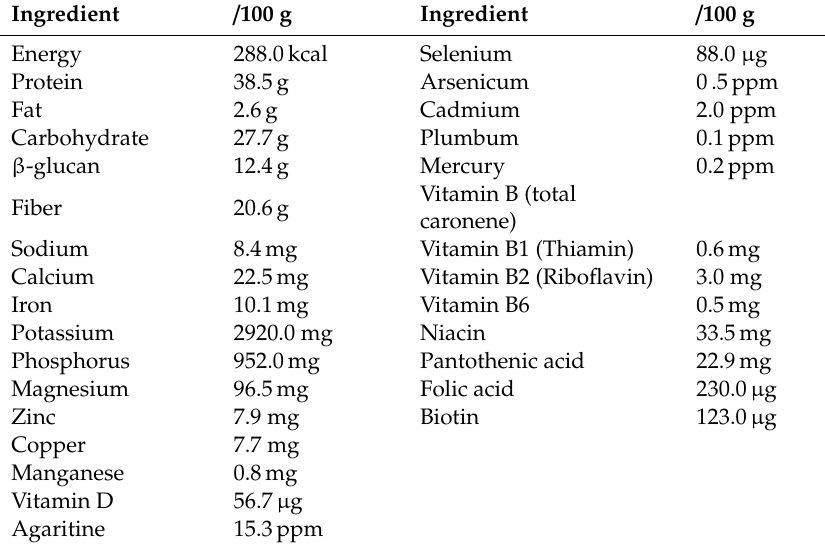
Table 1. Composition of Agaricus brasiliensis